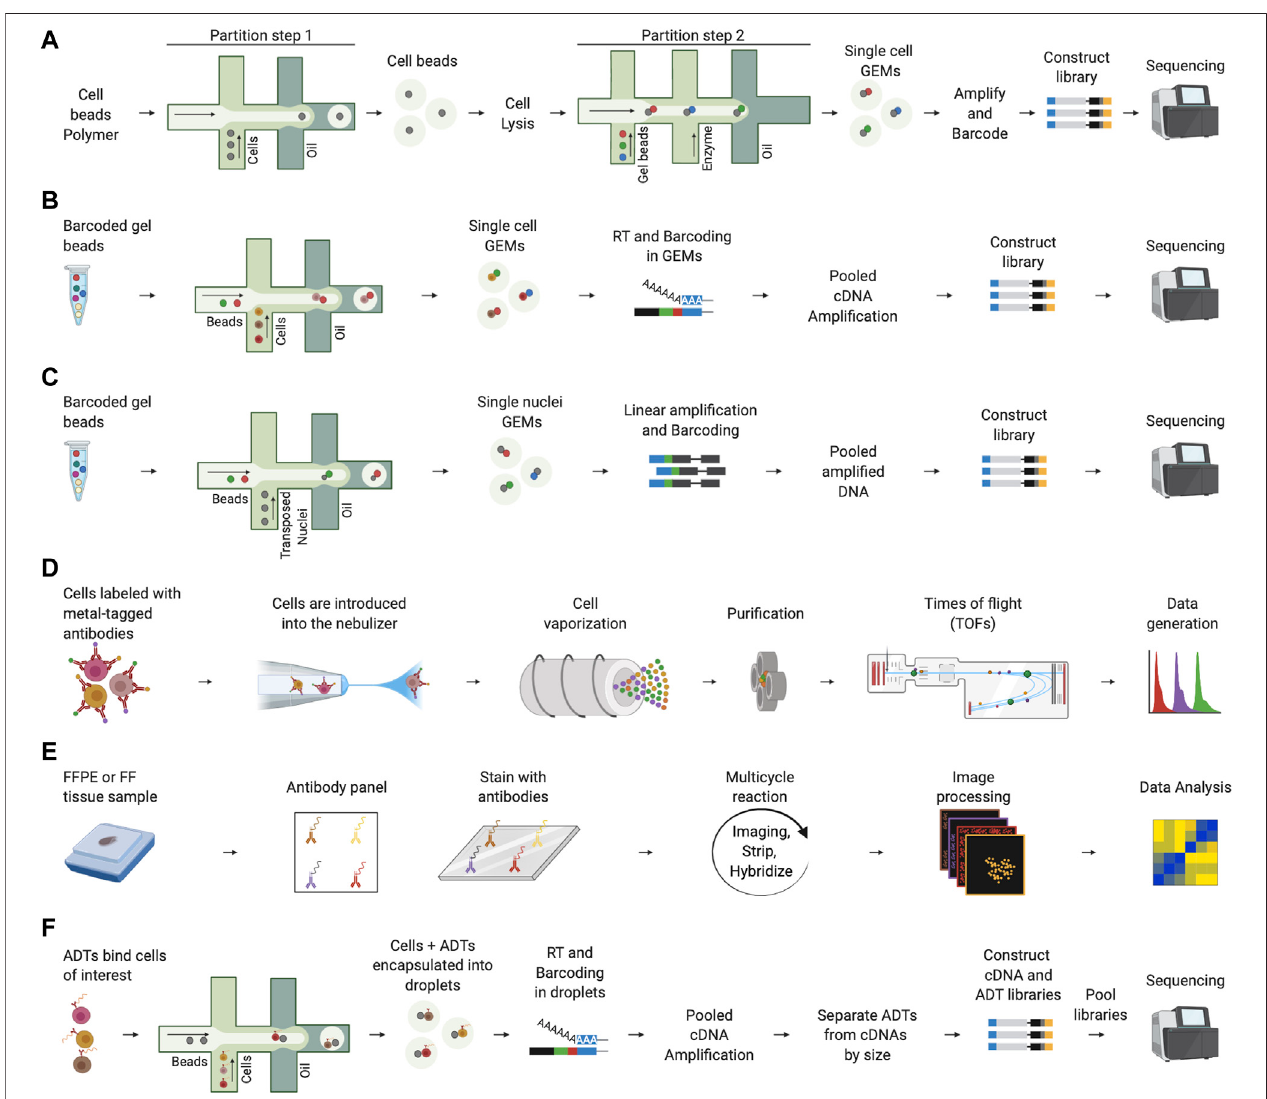
FIGURE 2 | Representative single-cell technologies to study the TME. (A) 10x Genomics single-cell genomics involves two steps of encapsulation using the micro fl uidicssystem.Inthe fi rststep,cellsarepartitionedusingacellbeadspolymer.TheobtainedcellbeadsarelysedtodenaturethegenomicDNAandasecondstep on micro fl uidics chip is performed to encapsulate cell beads with barcode gel beads. After collecting single cell GEMs, ampli fi cation and barcoding of fragments is performed prior to breaking the emulsion and constructing the library for sequencing. (B) In 10x Genomics scRNA-seq, cells are encapsulated into droplets together with barcoded beads. Next, reverse transcription (RT) is performed in the collected GEMs and barcoded cDNAs are ampli fi ed for library construction and sequencing. (C) In10xGenomicsscATAC-seq,nucleiaretransposedandencapsulatedintodropletsusingthemicro fl uidicschip.Next,thecollectedsinglenucleiGEMs are linearly ampli fi ed, and barcoded accessible DNA fragments are obtained after breaking the emulsion. Finally, DNA fragments are ready for library construction and sequencing. (D) In CyTOF, the cells are labeled using stable heavy metals, nebulized, and vaporized to form ion clouds through an argon plasma torch. Each cloud passesthroughaquadrupolewhichperformsapuri fi cationstep,theremainingheavyionsarequanti fi edbyatime-of- fl ight(TOF)massspectrometerthatdeterminesthe value of each marker. (E) In co-detection by indexing (CODEX), FFPE or FF tissues samples are stained with DNA-barcoded antibodies. Next, a multicycle reaction characterized by iteratively imaging up to three antibodies and nuclear stain, stripping and hybridizing is performed. This process is performed for all antibodies. Finally, raw images are processed and analyzed. (F) In CITE-seq, antibody-derived tags (ADTs) are used to bind the cells of interest. Next, cells are incapsulated into droplets using a micro fl uidics platform and after cell lysis in droplets, mRNAs and ADTs are barcoded during the RT. After ampli fi cation, cDNAs and ADTs are separated by size, converted into two independent libraries that are, fi nally, pooled, and